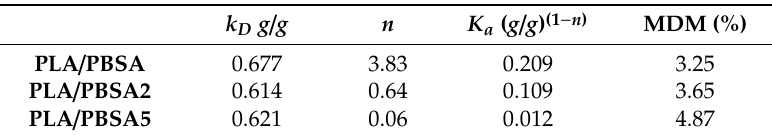
Table 8. Modelling parameters for the PLA / PBSA, PLA / PBSA2 and PLA / PBSA5 multilayer films.